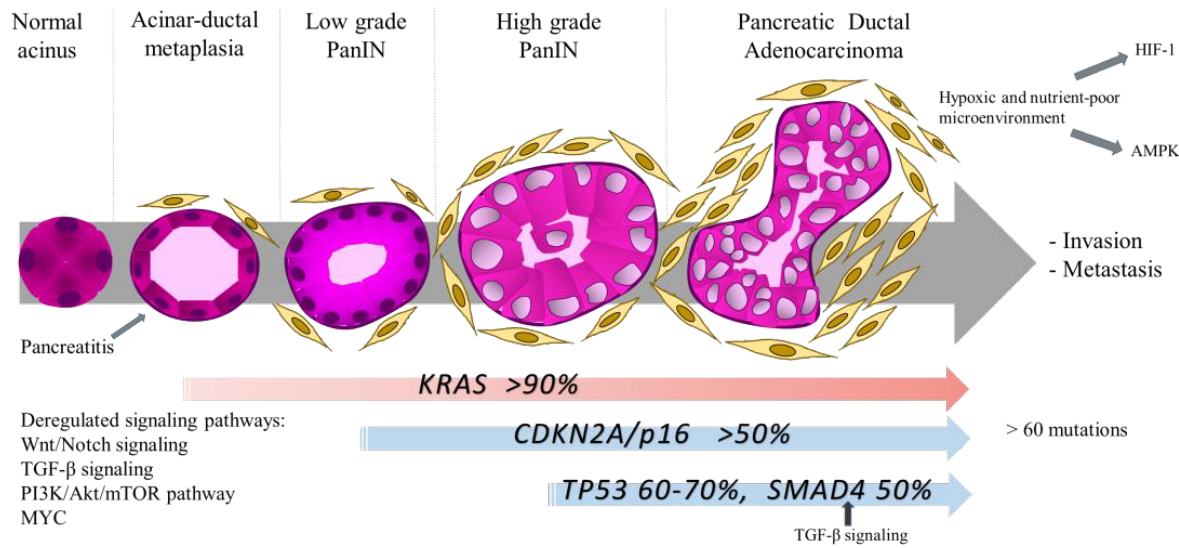
Figure 2. Schematic representation of genetic and signaling pathways alterations in PDAC carcinogenesis. PDAC arises from precursor lesions which are acinar-ductal metaplasia and Pancreatic Intraepithelial Neoplasia (PanIN). KRAS mutations are an early event in low grade PanIN and further mutations in tumor suppressor genes as CDKN2A / p16, TP53 and SMAD4 are present in high grade PanIN lesions, contributing to disease progression. Mutations in these four genes are by far the most common in PDAC; however, PDAC can harbor more than 60 mutations. Besides genetic alterations, deregulated signaling pathways and stromal-associated factors promote an aggressive PDAC behavior. Akt, protein kinase B; AMPK, adenosine monophosphate-activated protein kinase; CDKN2A / p16, cyclin dependent kinase inhibitor 2A; HIF-1, hypoxia-inducible factor; mTOR, mammalian target of rapamycin; PI3K, phosphatidylinositol 3-kinase; SMAD4, Mothers against decapentaplegic homolog 4; TGF- β signaling, transforming growth factor- β